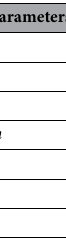
Table 1. The dimension of the coil unit.